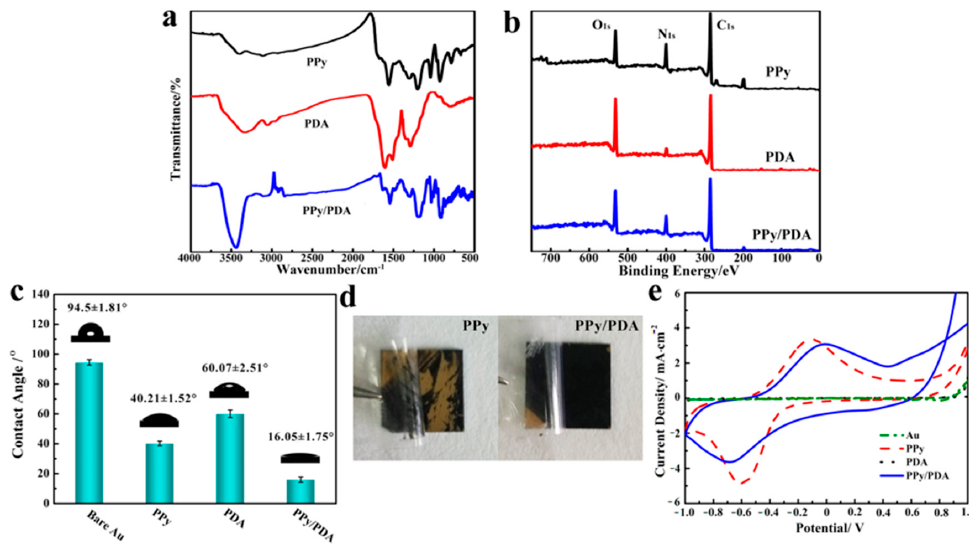
Figure 4. ( a ) FITR spectra of pure PPy NWs, PDA and PPy / PDA nanocomposite NWs. ( b ) XPS spectra of PPy NWs, PDA and PPy / PDA nanocomposite NWs. ( c ) The water contact angle of di ff erent material substrates. ( d ) The adhesion test of pure PPy NWs and PPy / PDA NWs. ( e ) Cyclic voltammogramms of di ff erent materials in 0.9% NaCl solution at the scan rate of 10 mV /